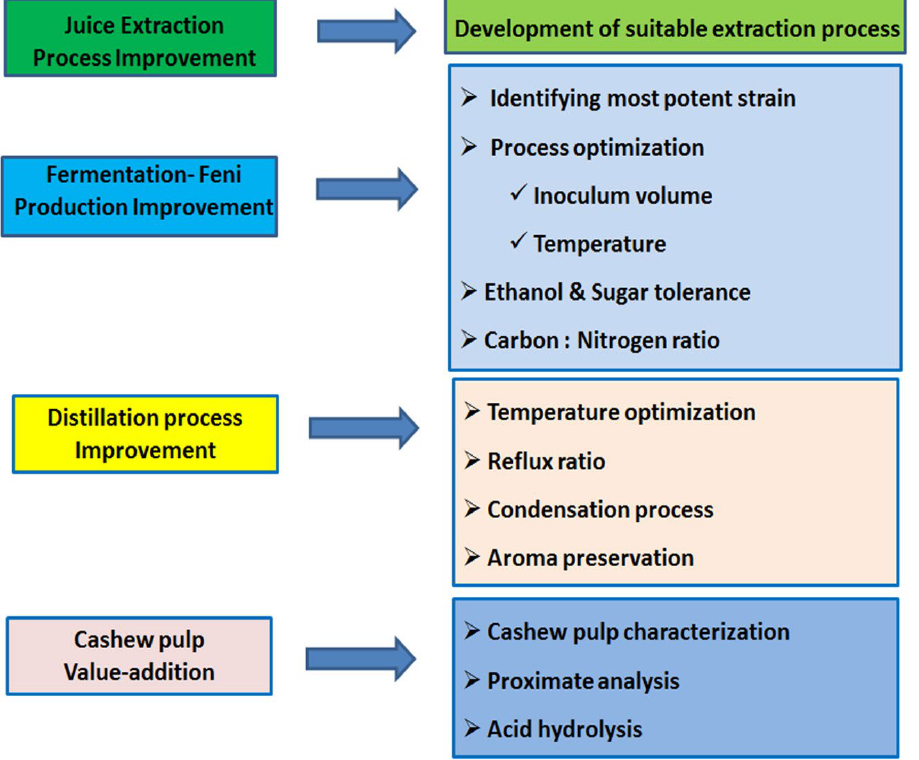
Fig. 6. Proposed process modifications for improved Feni